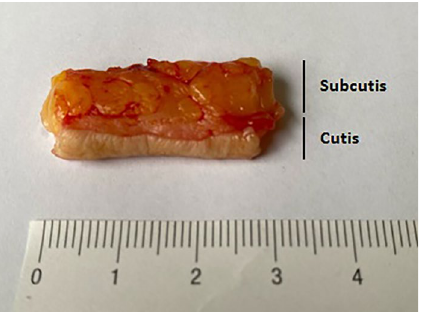
Figure 2. Skin samples measured approximately 3 × 0.5 × 2 cm and consisted of the skin layers cutis and